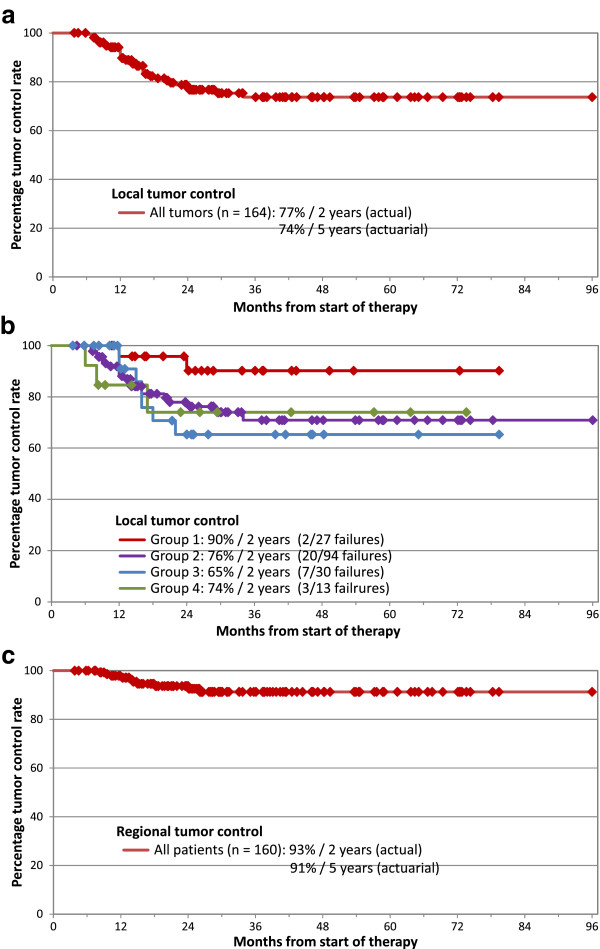
Kaplan-Maier plots for a) local tumor control all tumors; b) local tumor control by tumor size groups; c) regional tumor control all patients.